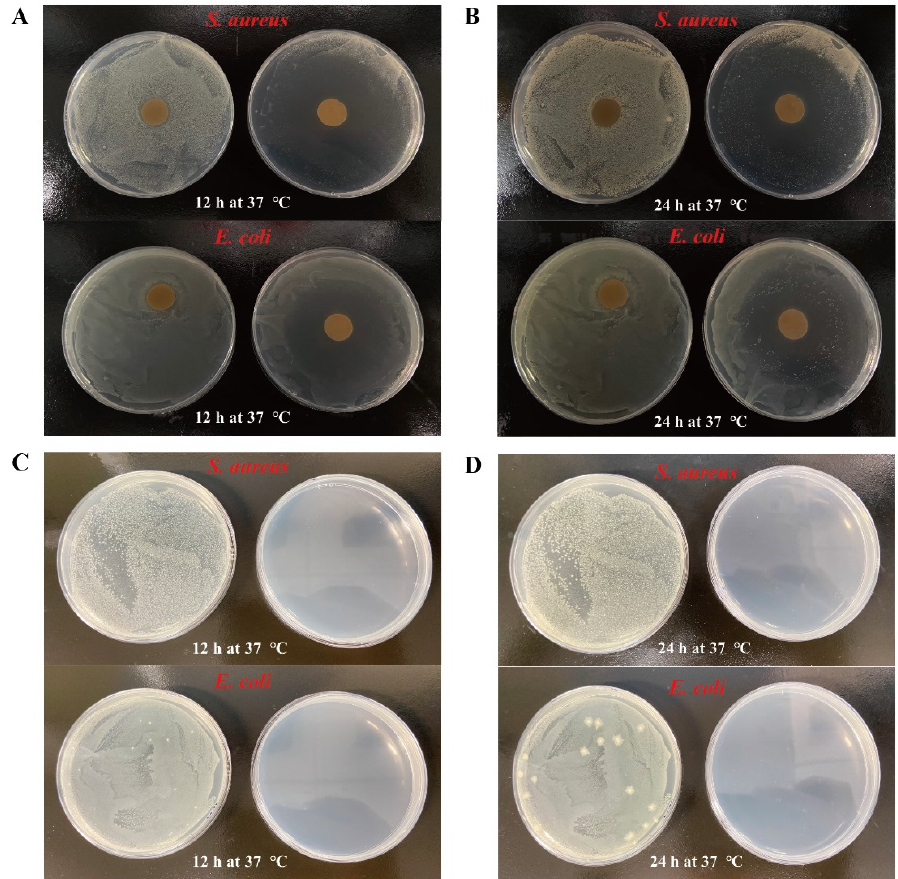
Figure 9. Digital photos of the inhibitory effect ( A , B ) and bacterial colonies ( C , D ) of S. aureus and E. coli after incubation with WMPI-GA coacervates and carvacrol microcapsules for 12 and 24 h.